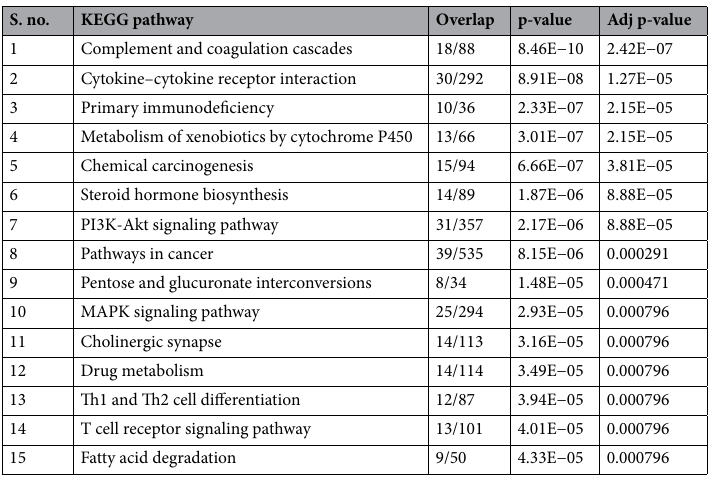
Table 2. Pathway enrichment of nodes that showing significant change in entropy (FDR < 0.05) between young (3–6 months) and old (24–27 months) mice with absolute mean difference greater than